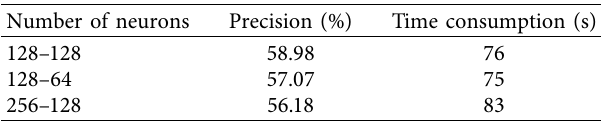
Table 5: Training precision and time for different numbers of